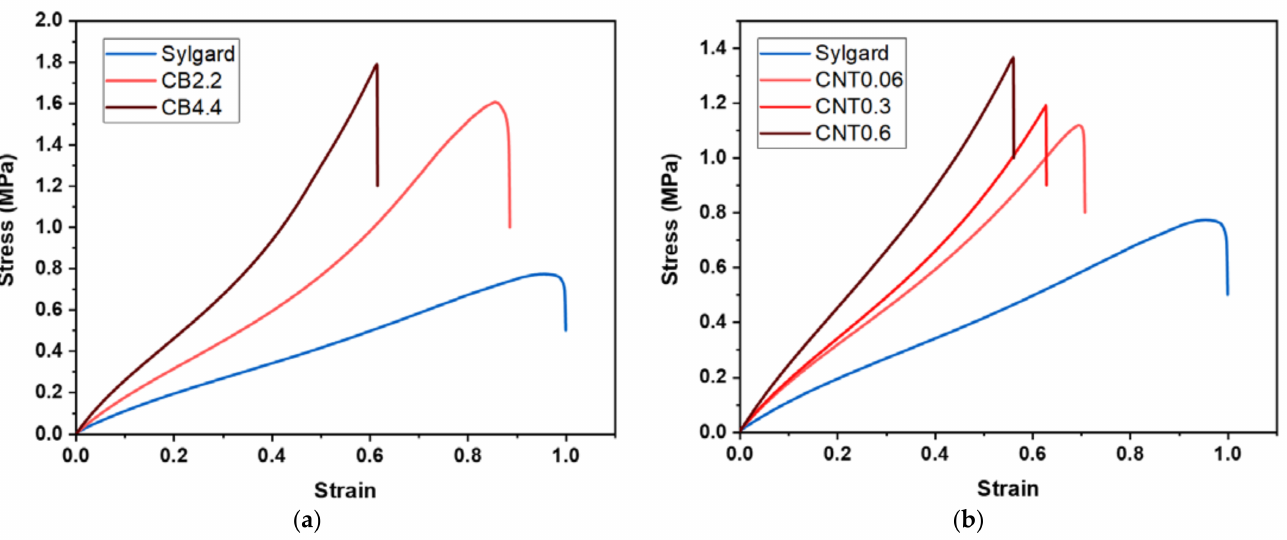
Figure 6. Tensile test results; ( a ) stress-strain curves for Sylgard composites containing CB; ( b ) stress-strain curves for Sylgard composites containing